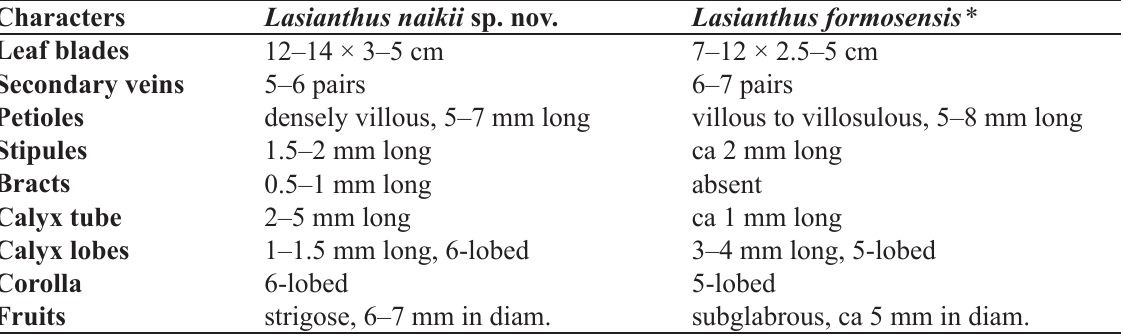
Table 1. Comparison of Lasianthus naikii V.S.Dang & Vuong sp. nov. and L. formosensis Matsumura. * = from Zhu & Taylor